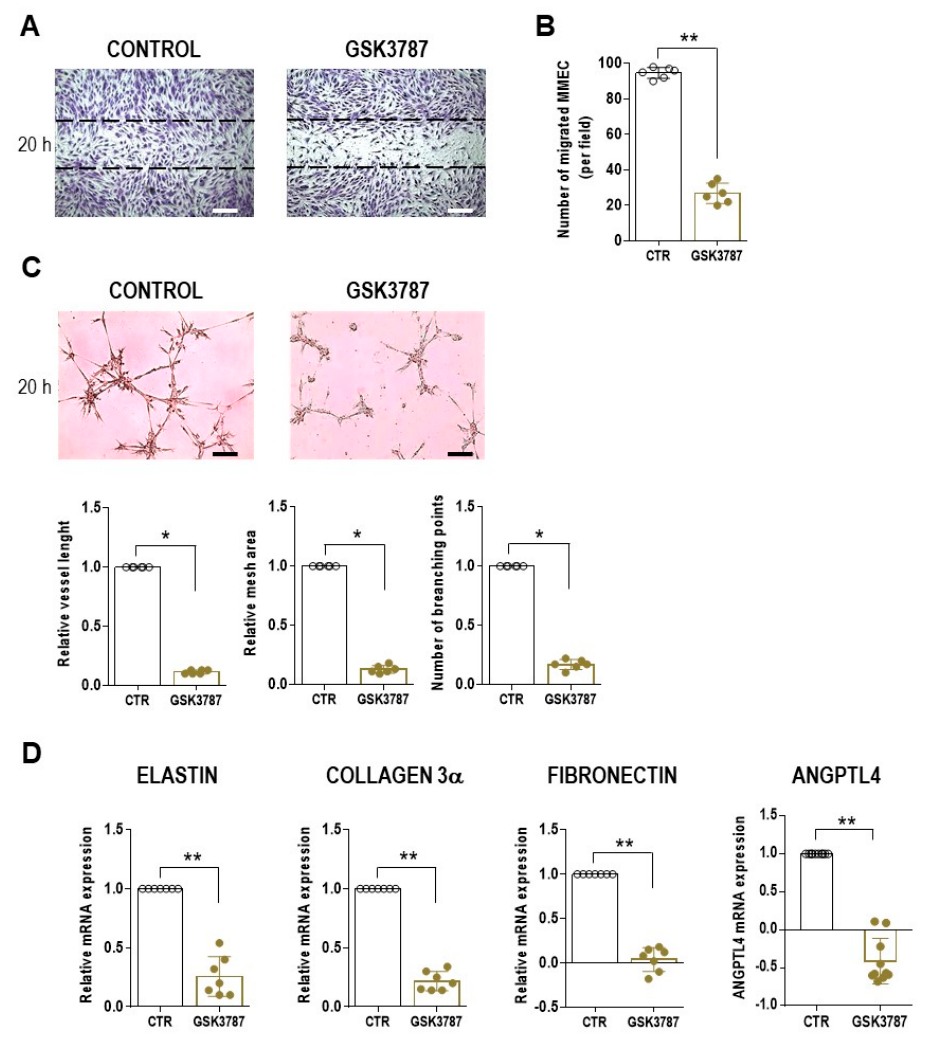
Figure 6. Inhibition of in vitro MMEC migration and angiogenesis by a PPAR β / δ antagonist. MMEC were cultured in serum-free medium alone (control) or containing 1 µM GSK3787 for 20 h. ( A ) Confluent monolayers of MMEC were subjected to a wound-healing assay. Photographs were taken 24 h after the wound was made. Dotted lines define the wound area. ( B ) Number of migrating cells in each wound of ( A ). ( C ) Matrigel angiogenesis assay. Representative micrographs of MMEC seeded on Matrigel and topological analysis. 200 × ; Scale bar, 50 µ m. Data are the mean ± SD of six independent experiments and were normalized to the control. * p < 0.05, ** p ≤ 0.01, Mann- Whitney test. ( D ) Relative mRNA levels of elastin, collagen 3 α , fibronectin, and ANGPTL4 in MMEC. The values were normalized to those of the control and determined by real time-PCR and the 2 − ∆∆ Ct method. ** p ≤ 0.01, Mann–Whitney